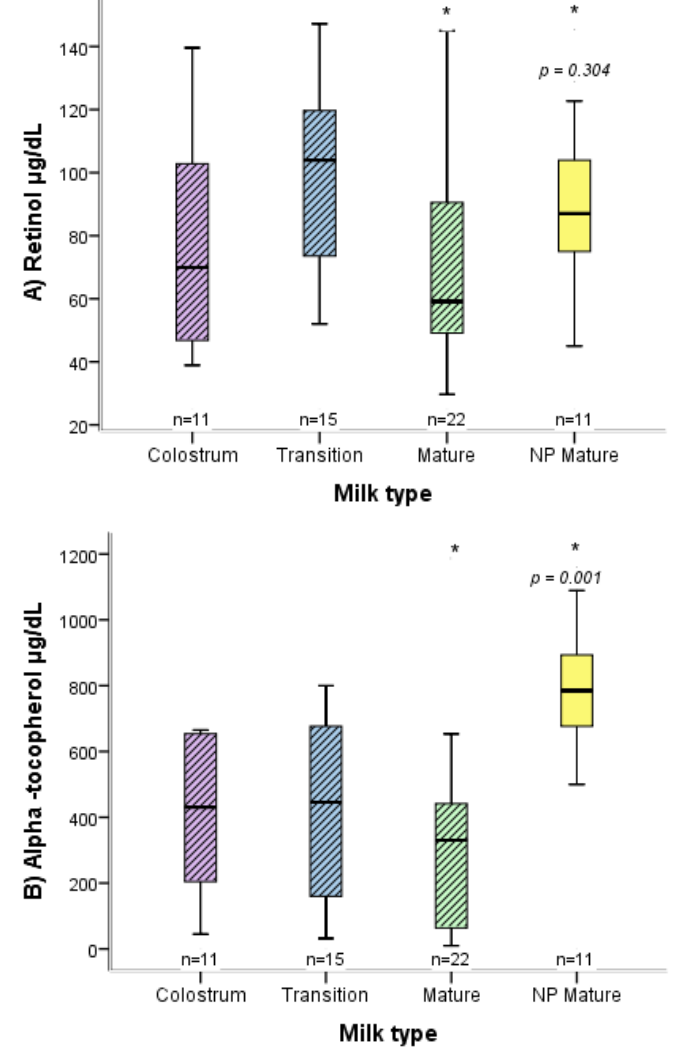
Figure 1. Box plot distribution of the concentration of retinol ( A ) and α -tocopherol ( B ) in breast milk, comparing the women with a full-term, high-risk pregnancy to those with a normal pregnancy. For the high-risk pregnancy, the distinct types of breast milk are shown (colostrum, transition milk, and mature milk). * p ; Mann-Whitney U . The bottom and top of the box represent the first and third quartiles (IQR), and the band inside the box the median. The ends of the whiskers denote the lowest and highest values still within 1.5 IQR. Outlier values are not displayed. NP, normal pregnancy.